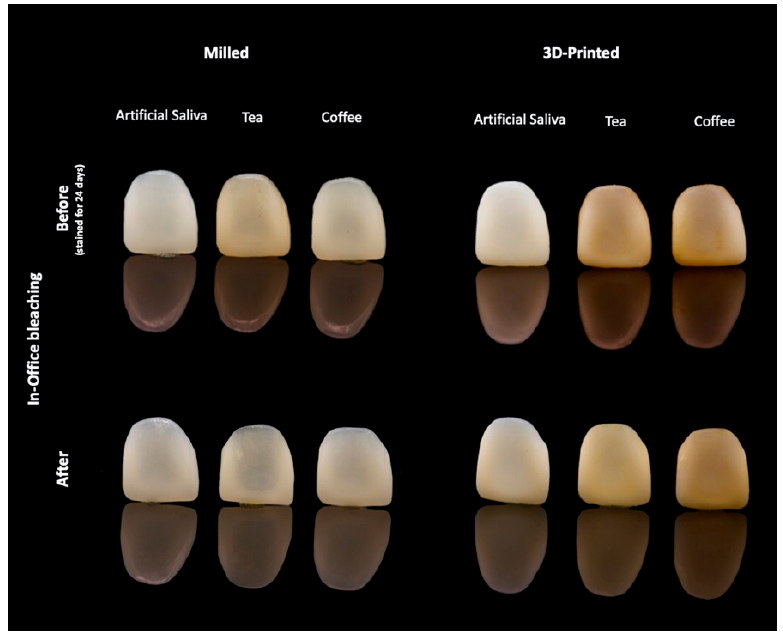
Figure 4. Photograph showing the effect of in-office bleaching in both 3D-printed and milled resto- ration groups.